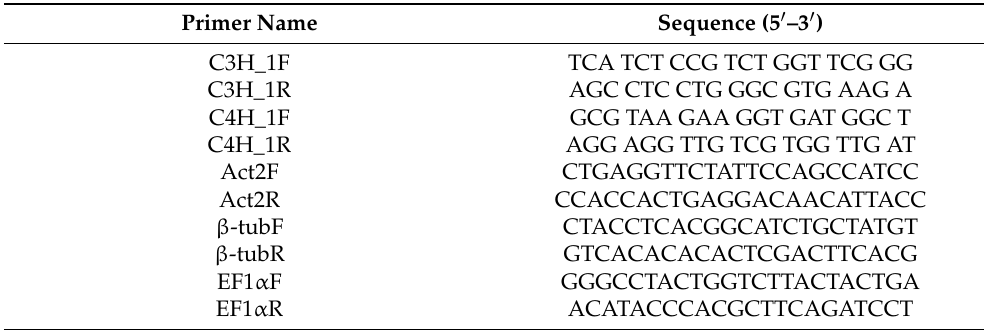
Table 2. Sequences of primers used as oligonucleotides for analyses of gene expression in maize leaves in response to water